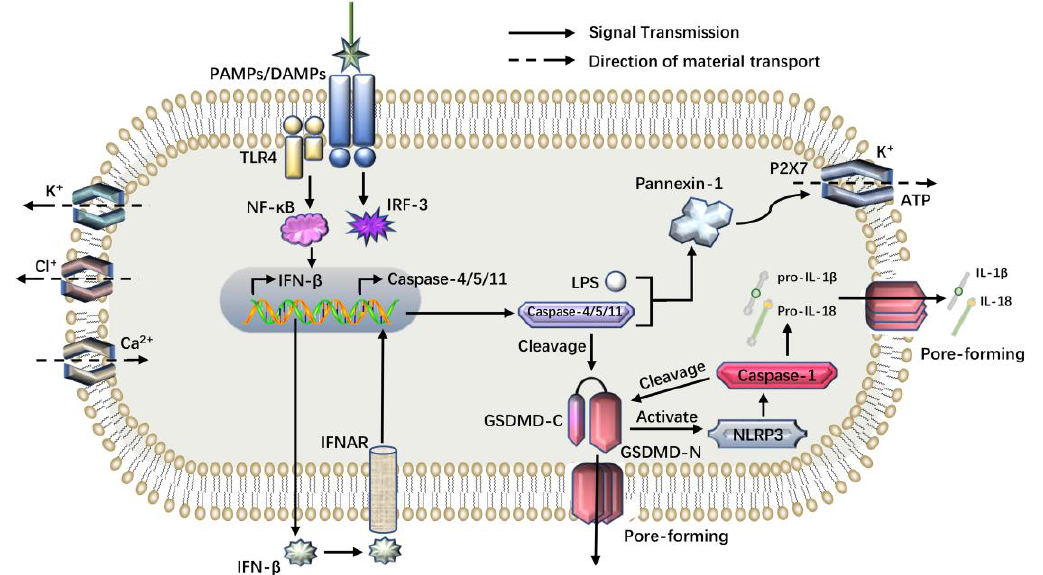
Figure 2. The noncanonical pyroptosis pathway. Endotoxin can activate caspase-11 in mice or caspase-4, 5 in humans to mediate the noncanonical pyroptosis pathway. After activated, caspa- se-4, 5, 11 cleave GSDMD to generate GSDMD-N, resulting in plasma membrane perforation. At the same time, GSDMD-N activates NLRP3, which activates caspase-1 and initiates the canonical pyroptosis pathway. In addition, by specifically binding to LPS, caspase-11 can facilitate the ex- pression of Pannexin-1. Activated Pannexin-1 activates the P2X7 channel, releasing ATP and K + , further damaging the integrity of the cell membrane. Endotoxin can also activate the NF- κB path- way and promote the expression and release of IFN-